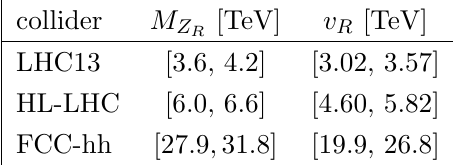
Table 2 . The lower bounds on the Z R boson mass M Z and the v R scale in the U(1) B (cid:0) L model R from the current LHC13 data [31, 32] and the prospects at the HL-LHC 14 TeV with an inte- grated luminosity of 3000 fb (cid:0) 1 [74, 75] and future 100 TeV collider FCC-hh with a luminosity of 30 ab (cid:0) 1 [34, 75]. The range in each case corresponds to the allowed range of r g from perturbativity constraints, as given in eq.